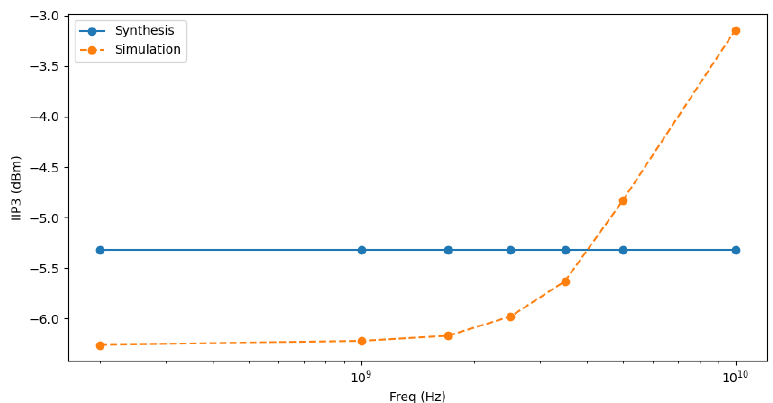
Figure 12. IIP3 (dBm) vs. frequency (Hz) for the first design point nominal corner. The synthesis results use the in-band gain which is frequency independent. The error is small in the frequency range of